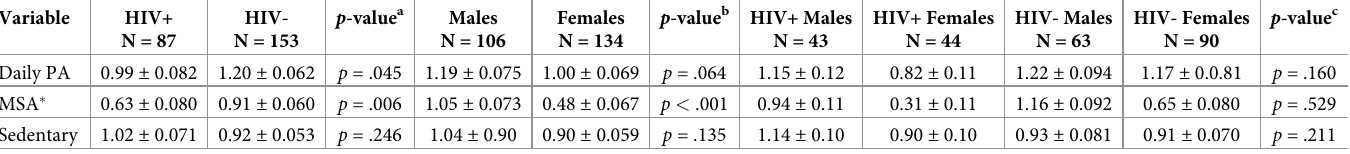
sex, controlling for age and BMI. The results indicated that there was not a significant interac- tion effect, F (3,232) = 1.36, p > .05. However, there were significant main effects for HIV status, = 0.04, and sex, F (3,232) = 12.27, p < .05, Z 2 = 0.14, which will be F (3,232) = 3.18, p < .05, Z 2 p p discussed because of limited research in this area and the relevance of these variables to the study’s objectives. An examination of univariate results indicted that the significant differences for HIV status were evident for daily PA, p < .05, and for muscle strengthening activities, p < .01. The mean differences showed that the HIV- group ( M = 1.20, SE = 0.06, CI = 1.08 to 1.32) had significantly higher daily PA than the HIV+ group ( M = 0.99, SE = 0.08, CI = 0.82 to 1.15 ) . The HIV- group ( M = 0.91, SE = 0.06, CI = 0.79 to 1.03) also had a significantly higher mean for muscle strengthening activities than the HIV+ group ( M = 0.63, SD = 0.08, CI = 0.47 to Table 2. Means and standard errors for daily PA, muscle strengthening and sedentary behavior by HIV status and sex. Variable HIV+ N =